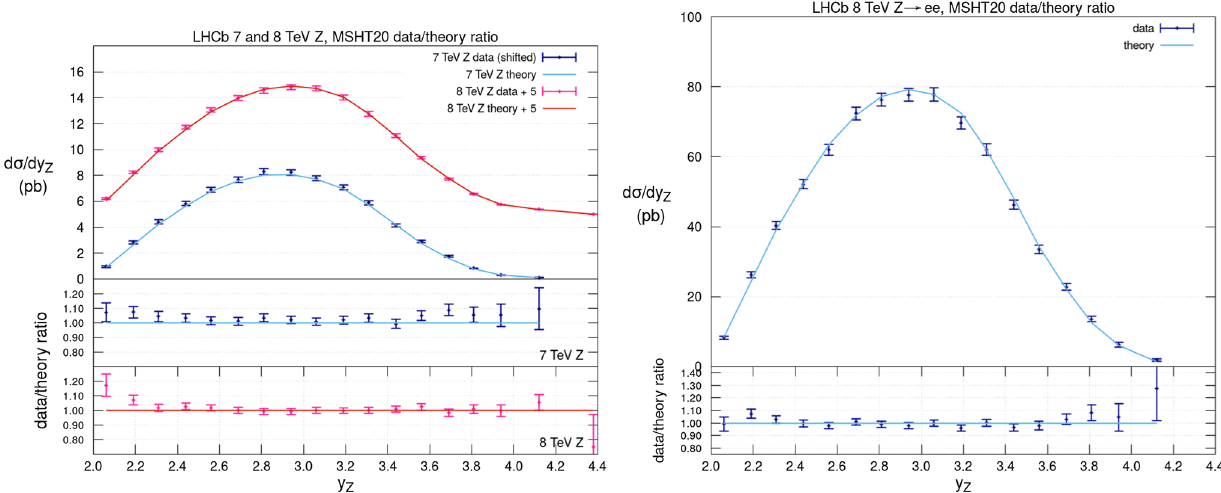
Fig. 9 Data vs. MSHT20 NNLO theory for the (left) LHCb 7 and 8 TeV Z data in the muon channel and (right) the LHCb 8 TeV Z in the electron channel, both differential in y Z . The errors plotted here are the total uncorrelated errors for each